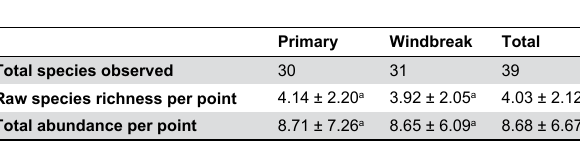
Table 1. Mean ± standard deviation of bird species richness, abundance in primary forests and windbreaks.